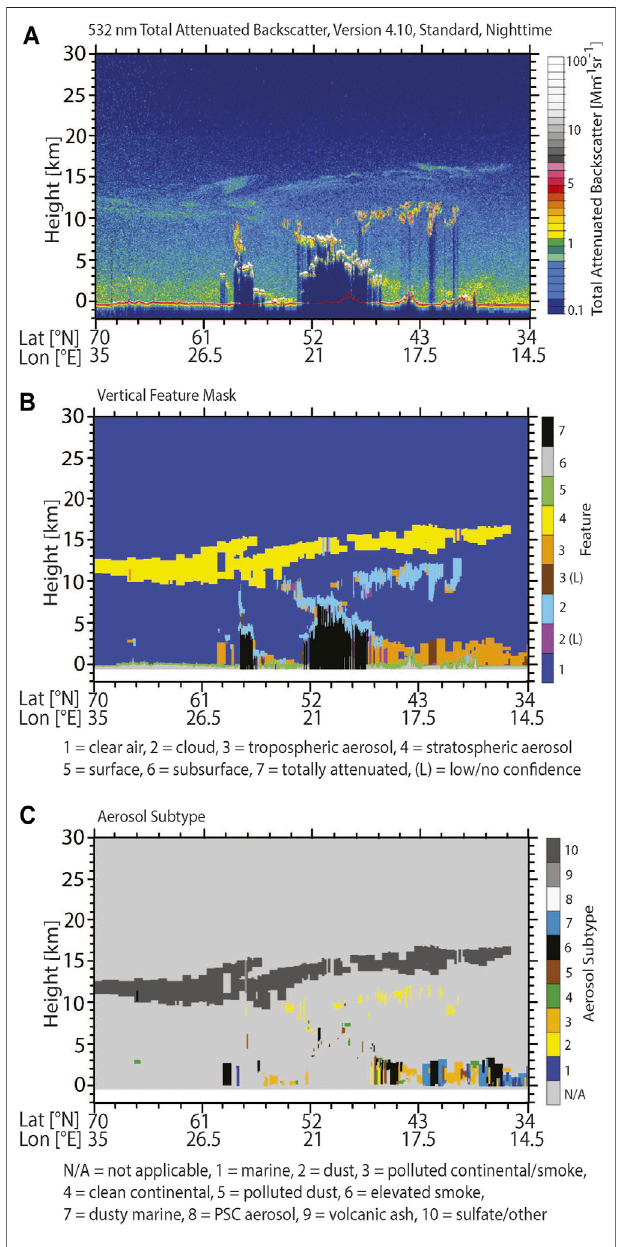
FIGURE 2 | CALIOP observation of aerosol and cloud layers along the northeast-to-soutwest fl ight track crossing Finland, Poland, and Italy ( Figure 1 ), about 450 km east of Leipzig on July 23, 2019, 1:02 – 1:17 UTC. (A) 532 nm attenuated backscatter coef fi cient, (B) vertical feature mask (VFM) indicating the basic layer type (aerosol or cloud layer), and (C) VFM for aerosol layers only (aerosol subtyping). The detected stratospheric aerosol layer [yellow in (B) ] is correctly classi fi ed as sulfate aerosol layer [type number 10 in (C) ].